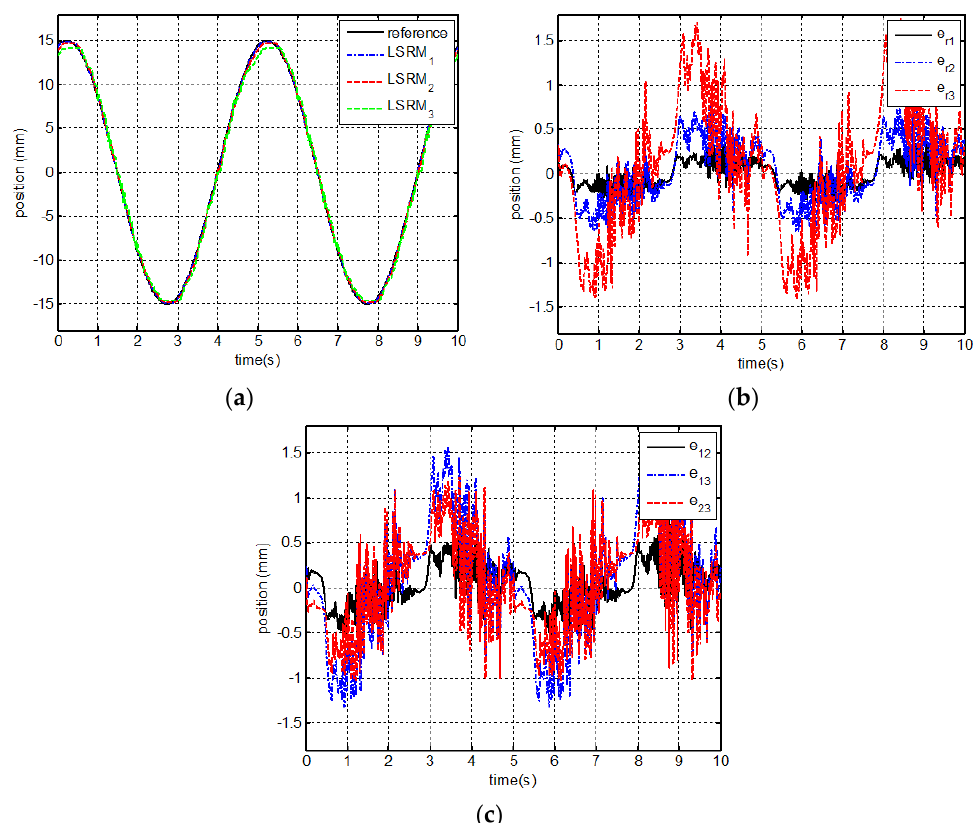
Figure 9. Tracking profiles: ( a ) LSRMs; ( b ) error to reference; and ( c ) relative error response with consensus algorithm only.